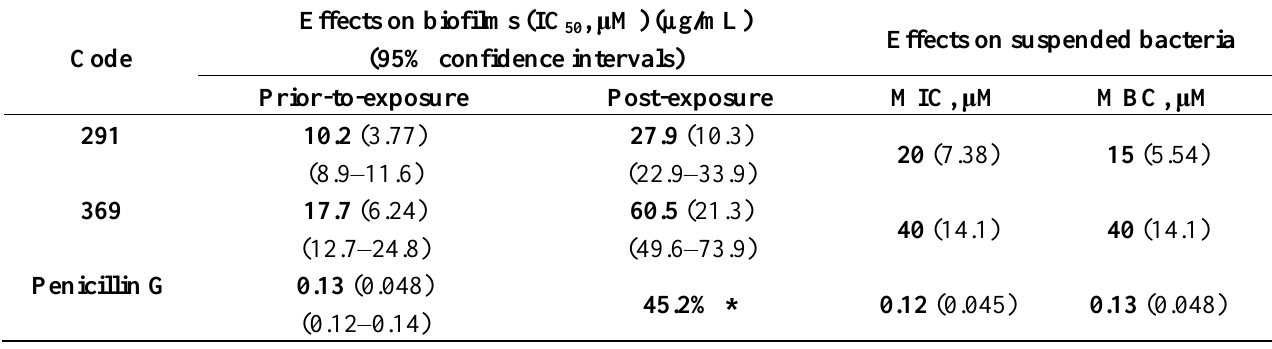
Table 2. Anti-biofilm and antibacterial potencies of the top two flavonoids (flavans 291 and 369 ). MIC, minimal inhibitory concentrations; MBC, minimal bactericidal